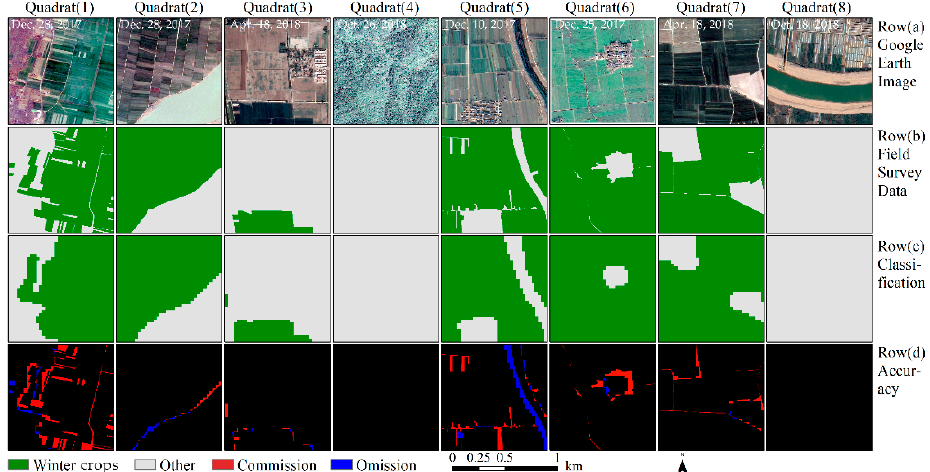
Table 3. Compared with public data at a provincial scale (km 2 ) .